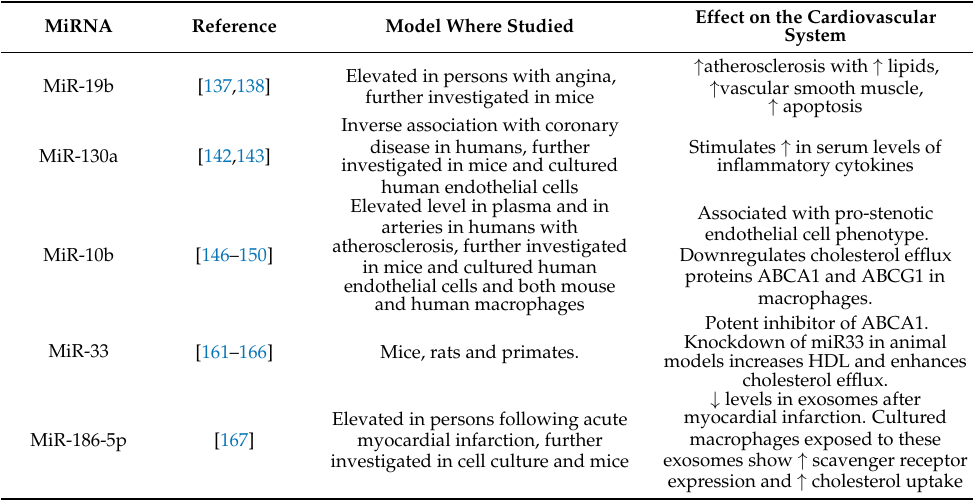
Table 2. Exosomal miRNAs pertinent to cardiovascular function and